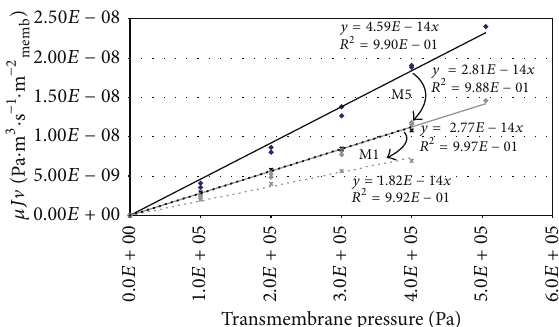
Figure 1: Extraction of the hydraulic permeabilities of different zeo- lite tubular membranes from the representation of the permeation fluxversusthetransmembranepressure(membranes1(dottedlines) and 5 (full lines) before (black) and after the alkaline treatment